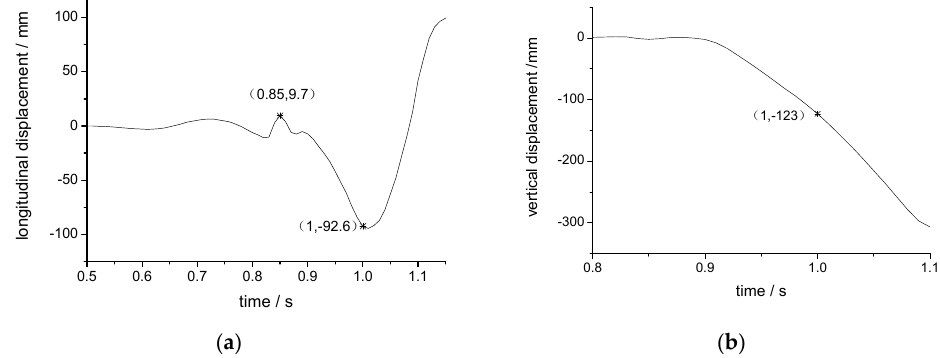
Figure 20. Displacement time history curve of the top middle pier: ( a )longitudinal; ( b )vertical.